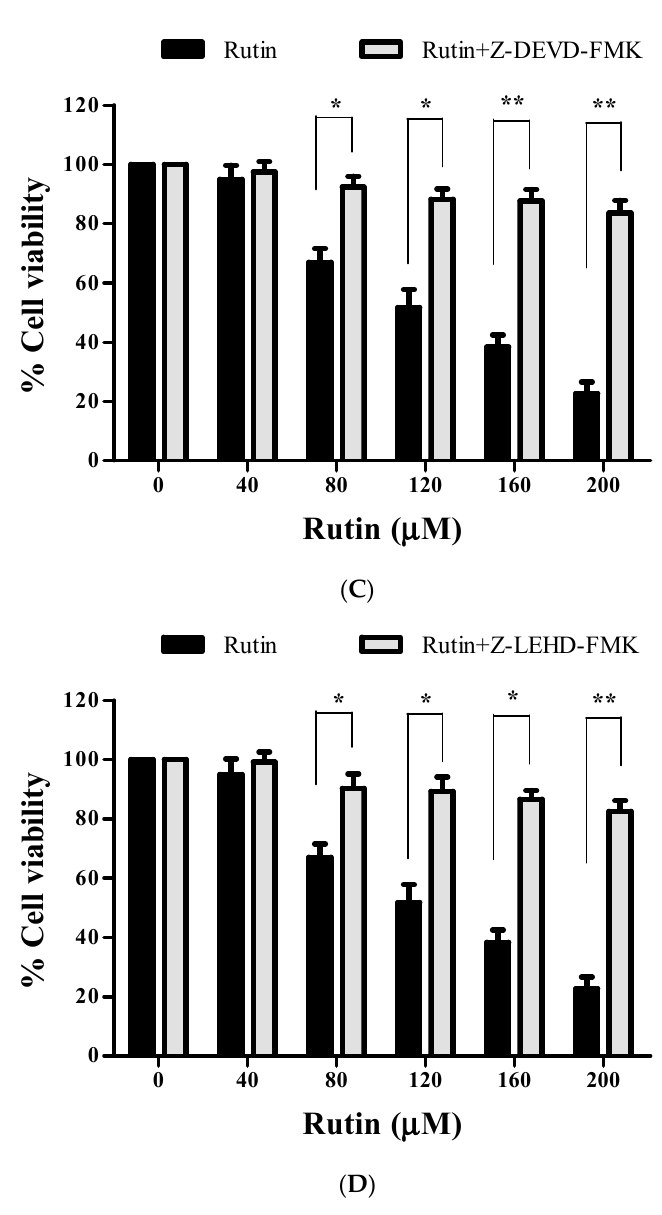
Figure 5. Rutin significantly induces caspase-mediated apoptosis in cervical cancer cells. ( A ) The mRNA expression of Caspase-3 and -9 in cervical cancer cells treated with rutin (80, 120, and 160 µM) was investigated by qRT PCR. ( B ) Enhanced activity of Caspase-3 and -9 in rutin-treated SiHa cells examined by caspase colorimetric kits using specific substrates. ( C , D ) Percent cell viability of SiHa cells pretreated with respective caspase inhibitors then treated with various concentrations of rutin (40–200 µM) for 24 h assessed by MTT assay. The results are represented as mean ± SEM of three independent experiments (* p < 0.01, ** p < 0.001 compared with control group).